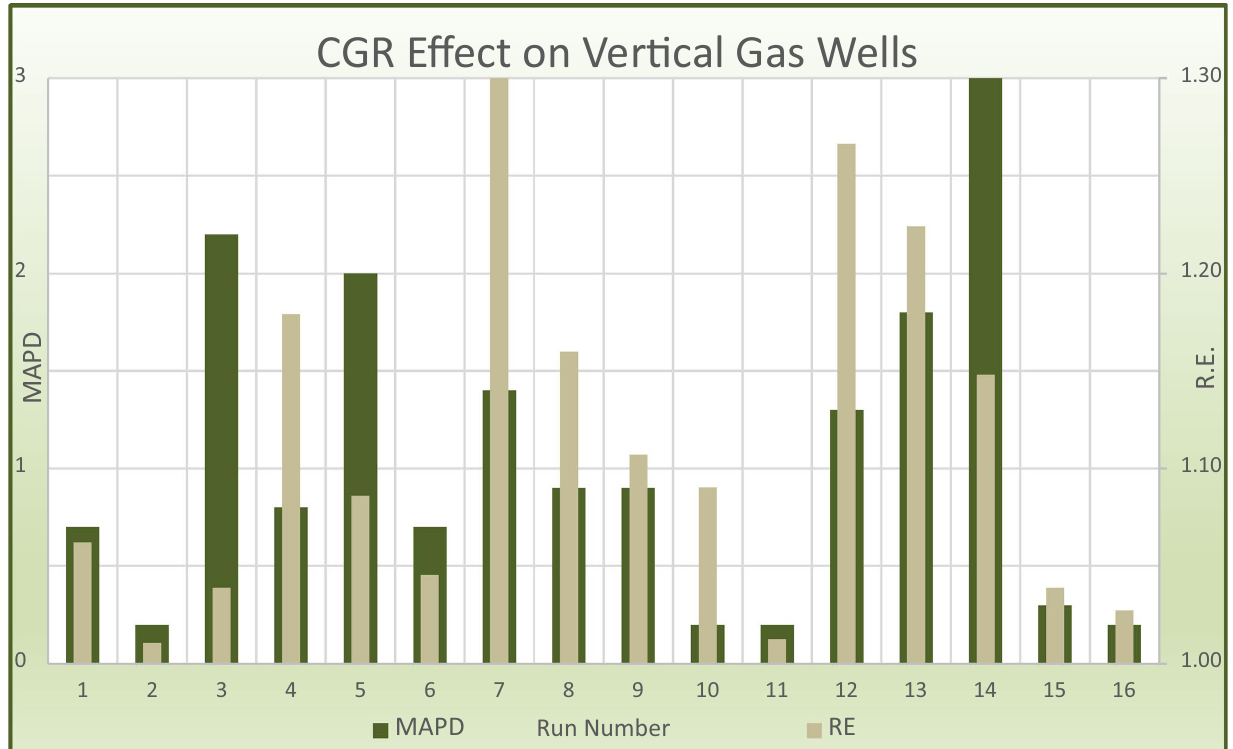
Fig. 1 Effect of CGR on vertical wells using MAPD and RE